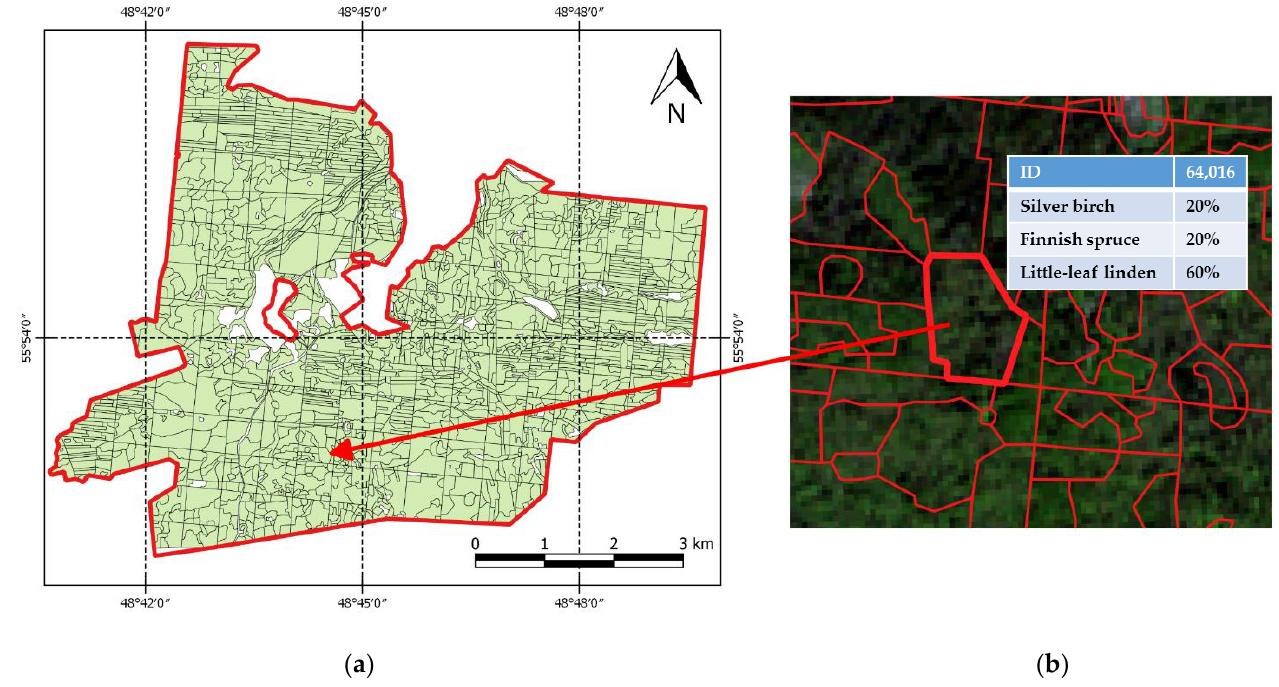
Figure 2. Map of forestry stands of the Raifa forest: ( a ) study area; ( b ) map fragment. Table 1. The presence of tree species in the Raifa forest. Tree Species